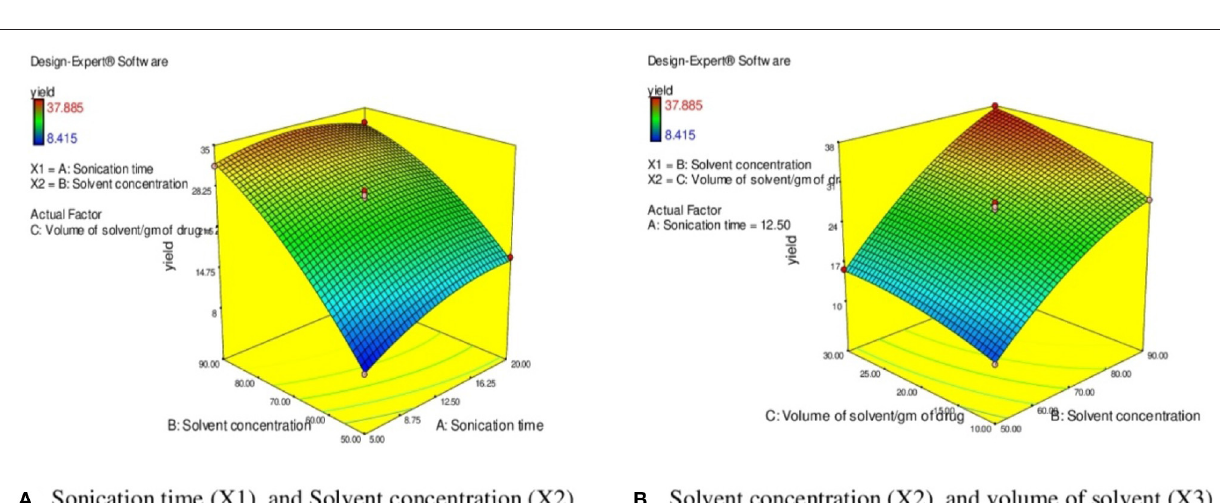
FIGURE 5 | 3 D diagram indicating the effect of different variables (X 1 , X 2 , X 3 ) on the response, % EY (Y) in UAE. (A) Sonication time (X l) and Solvent concentration (X2). (B) Solvent concentration (X2) and volume of solvent